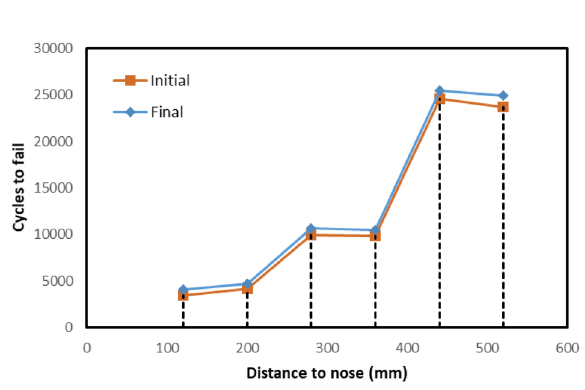
Figure 17. Fatigue lives of six different